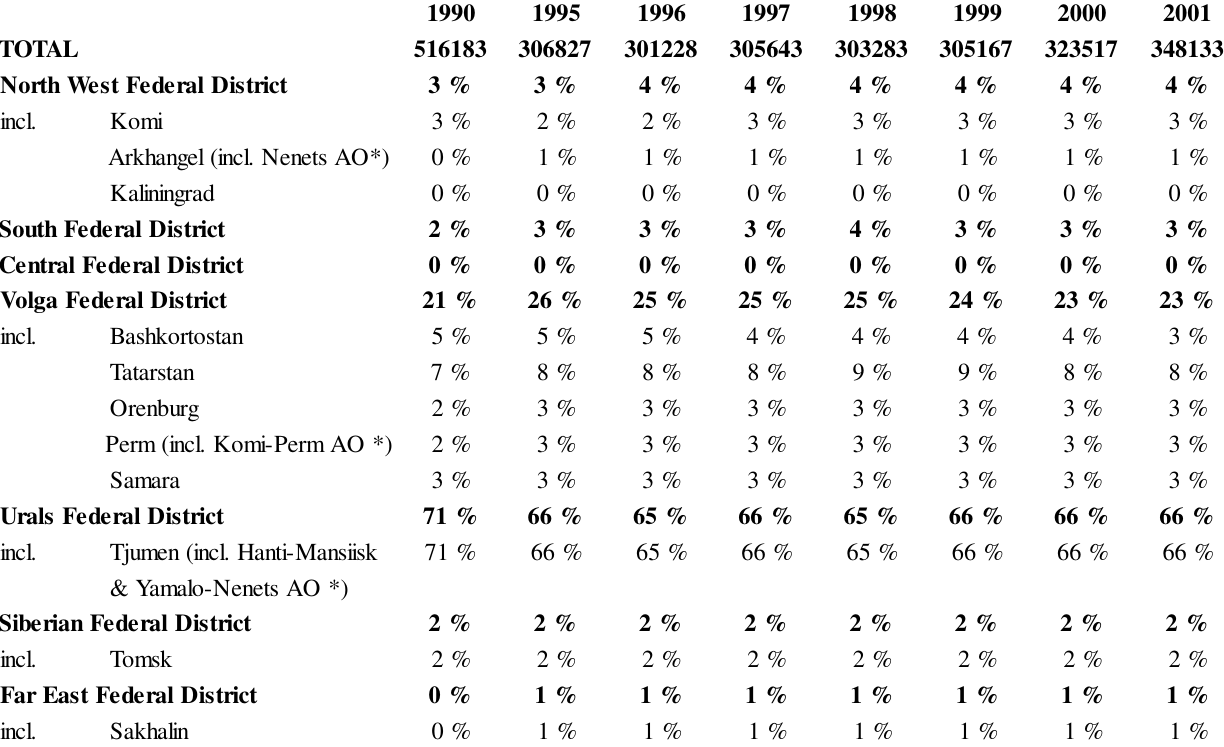
Table 5. The Development of Oil Production in the Russian Regions (1000